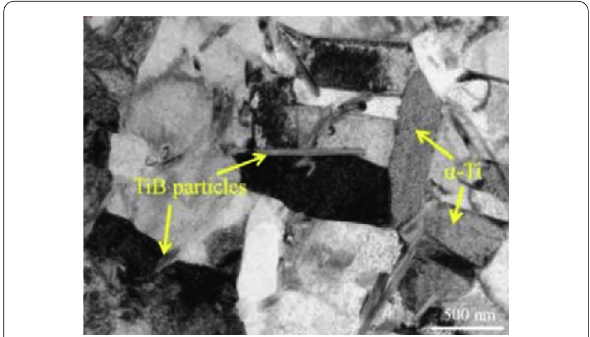
Figure 6 TEM image of the SLM-processed Ti-8.3 vol.% TiB composite